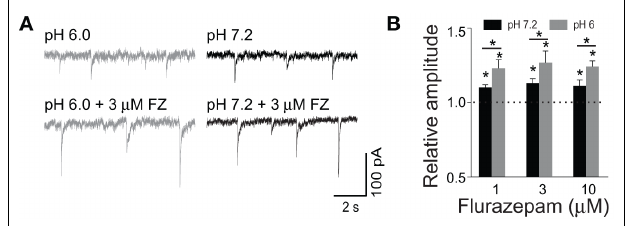
FIGURE 6 | Low pH increases mIPSC susceptibility to modulation by flurazepam. (A) Examples of mIPSCs recorded at − 70mV at pH = 6.0 (gray) and pH = 7.2 (black) in the absence (upper traces) and presence of 3 μ M flurazepam (lower traces). (B) Statistics of flurazepam effect on mIPSC amplitude at pH 7.2 (black bars), and at pH = 6.0 (gray bars). Note that the acidic pH increased the relative enhancement of mIPSC amplitude by flurazepam. Modified fromWojtowicz et al. (2008) with